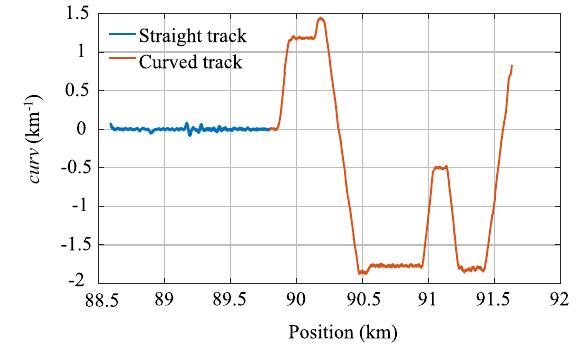
Fig. 4 The tricube